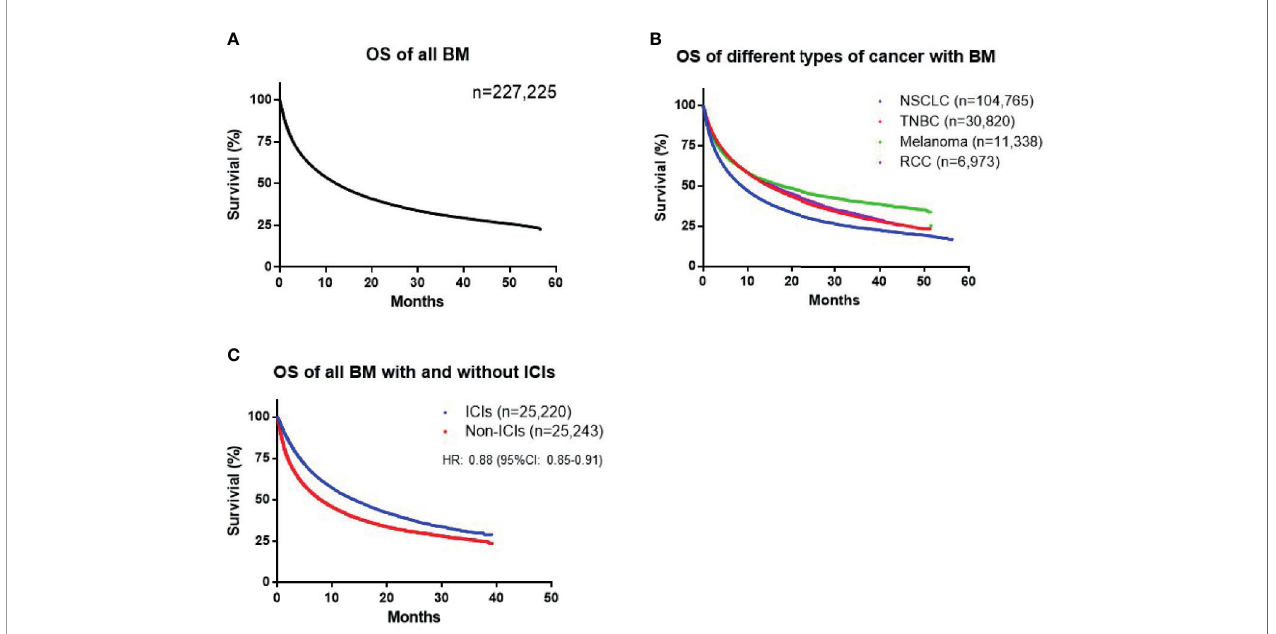
FIGURE 1 | (A) Overall survival (OS) of all patients with brain metastases (BM). (B) OS of patients with nonsmall-cell lung cancer (NSCLC), triple-negative breast cancer (TNBC), melanoma, and renal cell carcinoma (RCC). (C) Difference in survival between cohorts treated with and without immune checkpoint inhibitors (ICIs) among all patients with